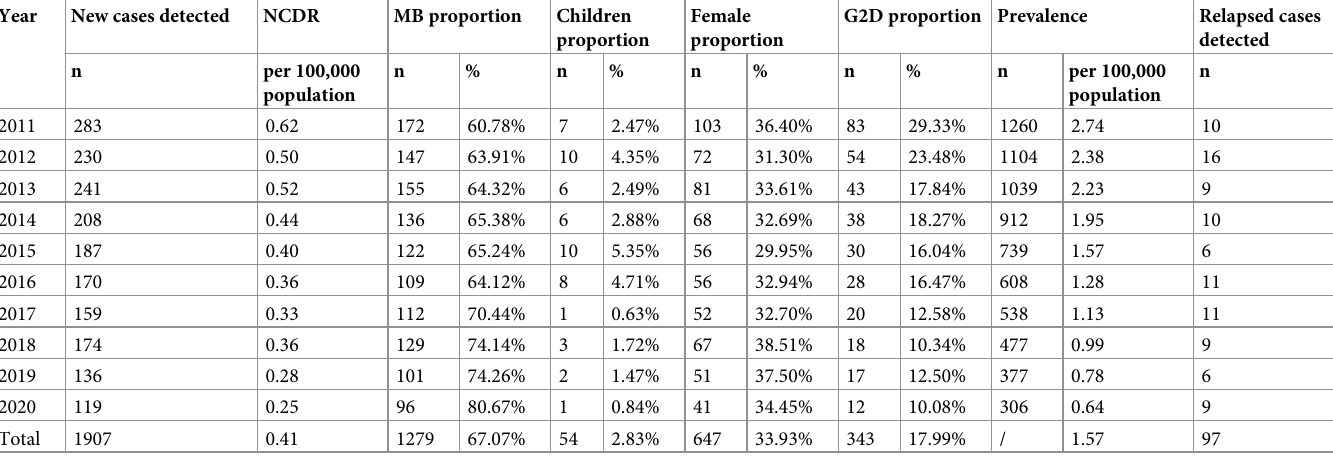
Table 1. Epidemiological Characteristics of Newly Detected Leprosy Cases in Yunnan, China,